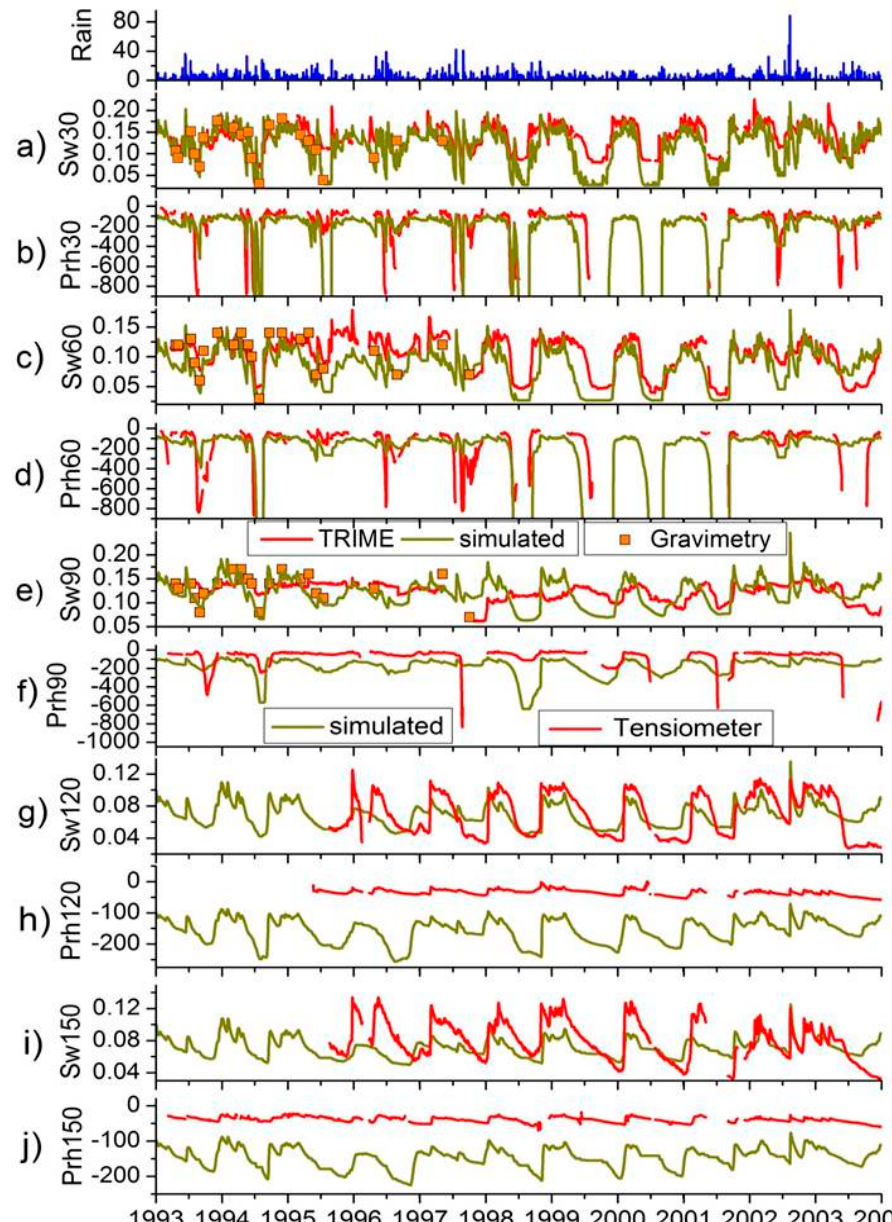
Figure 5. Daily rainfall (Rain) in mm d − 1 , simulated and measured soil water contents (TRIME, Gravimetry) in cm 3 cm − 3 at soil compartments 0–30 cm ( a , Sw30), 30–60 cm ( c , Sw60), 60–90